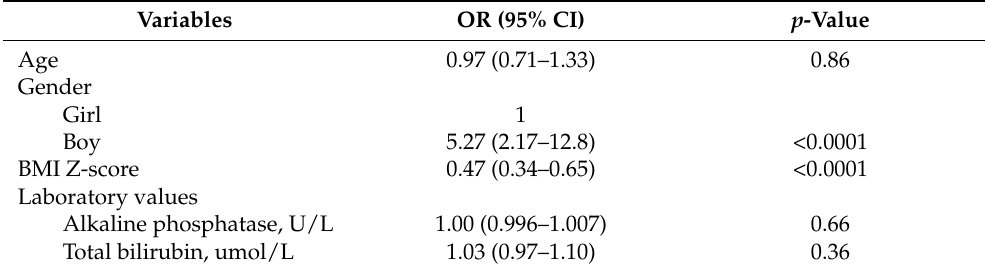
Table 3. Logistic regression analysis for independent predictors of BMD Z-score ≤ −